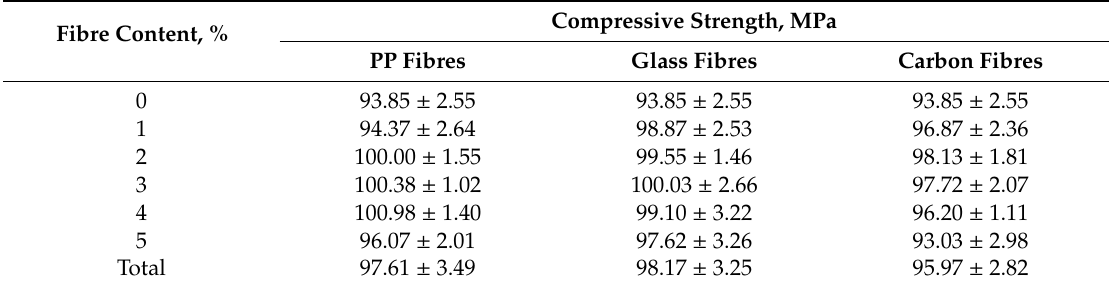
Table 9. List of average values of mortar compressive strength with standard Table 9 . List of average values of mortar compressive strength with standard deviation.